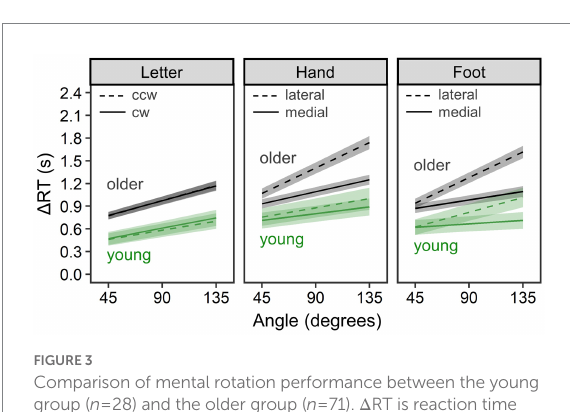
FIGURE 3 Comparison of mental rotation performance between the young group ( n = 28) and the older group ( n = 71). Δ RT is reaction time (RT) of the mental rotation task from which the mean choice RT was subtracted. Lines and error bands represent estimated means and their 95% credible intervals,